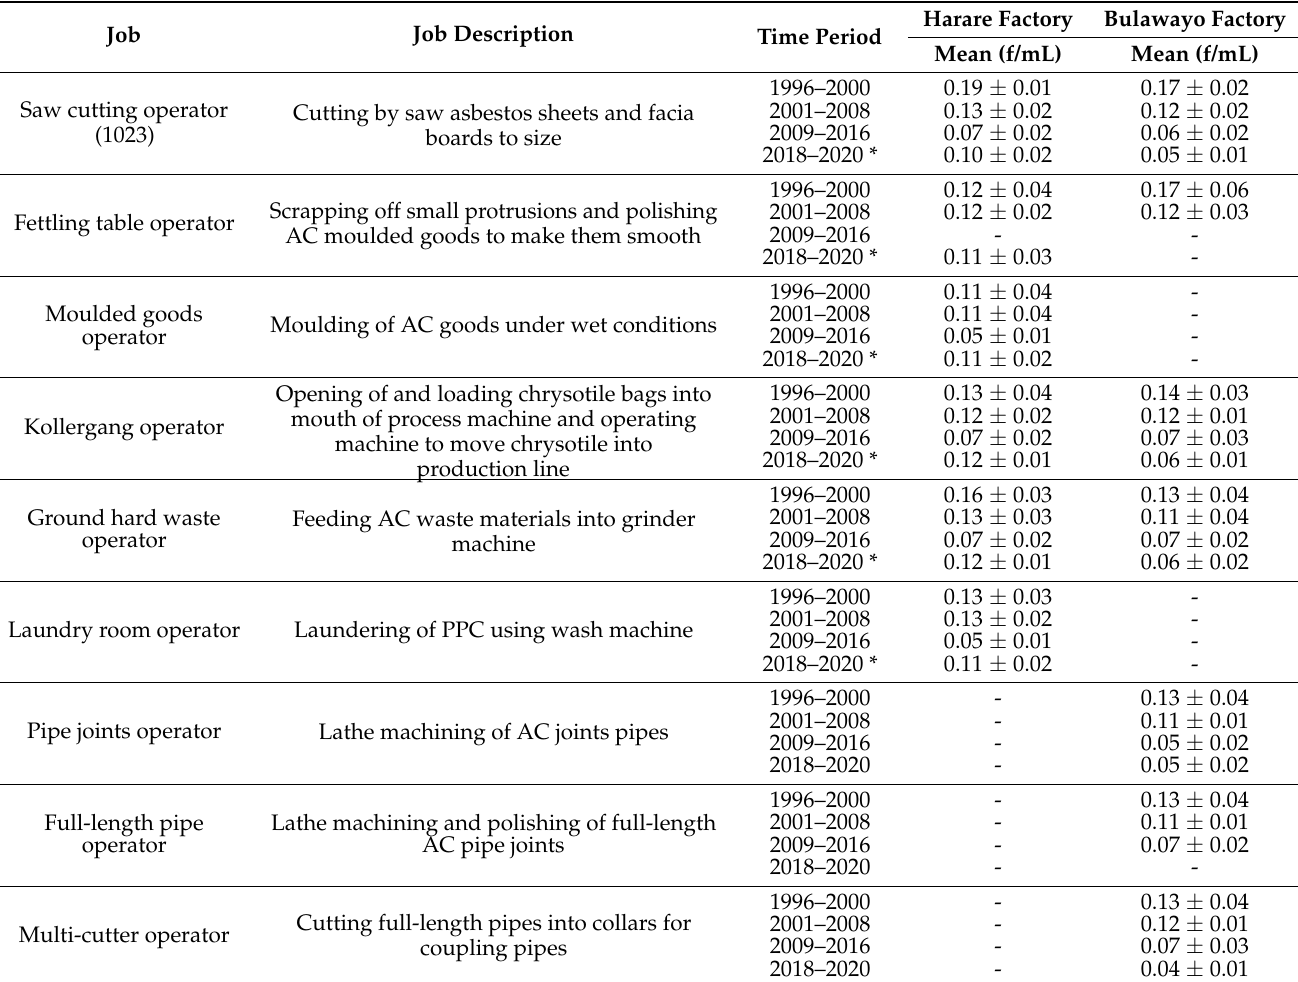
Table 2. Abridged job-exposure matrix based on mean airborne chrysotile exposure data per time- period and place for the period of